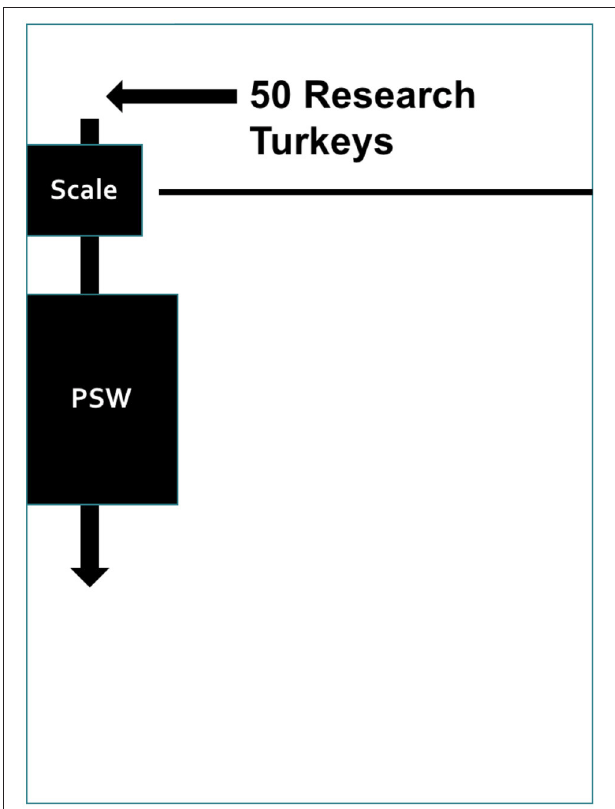
FIGURE 1 | A diagram of how the experimental pens were set up on sampling days. The 50 research turkeys were gathered behind temporary panels in the back of the barn. During sample collection each turkey was individually guided onto the scale, weighed, and then walked over the pressure sensing